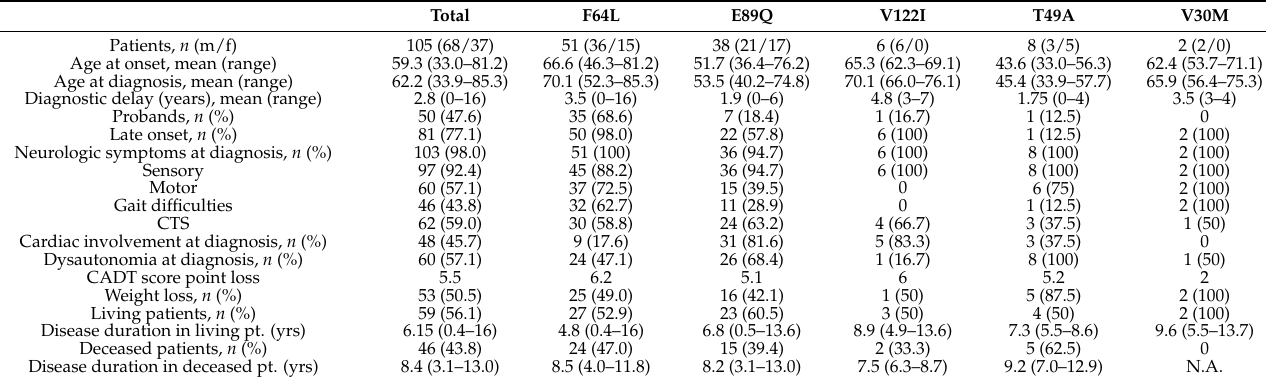
Table 1. Clinical characteristics. All time intervals are expressed in years. Total F64L E89Q V122I T49A V30M Patients, n